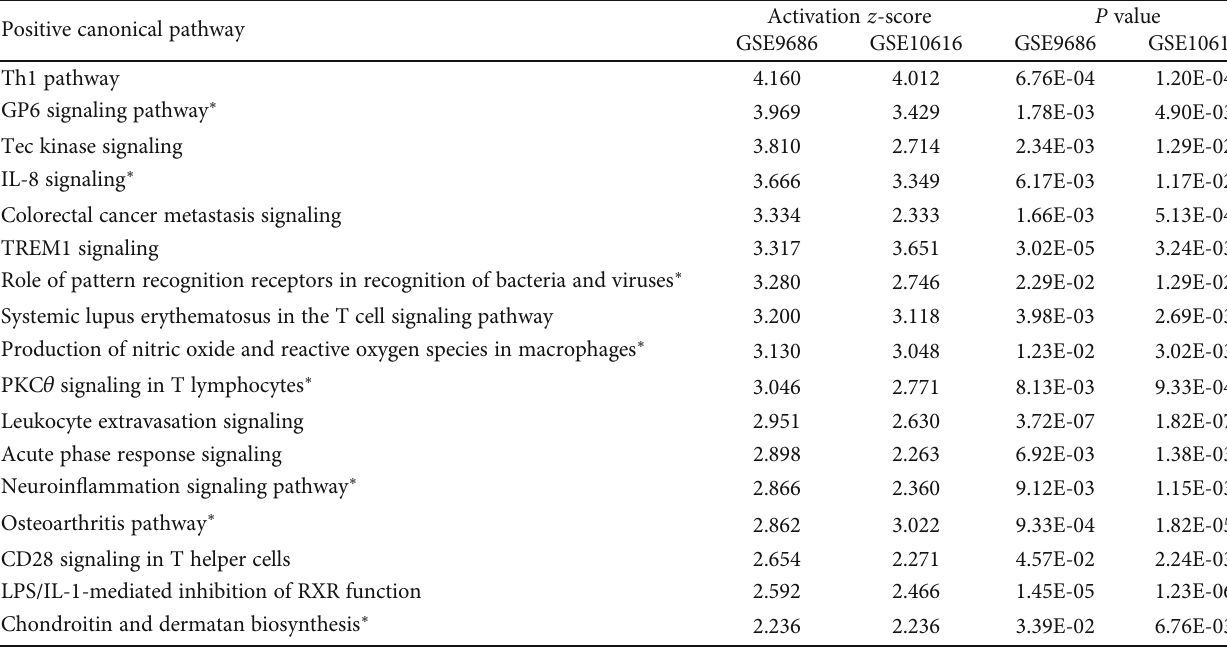
Table 2: Pathways that overlapped between expression pro fi ling data from two studies of colon biopsies of pediatric ulcerative colitis ( z ‐ score > 2 and P value <